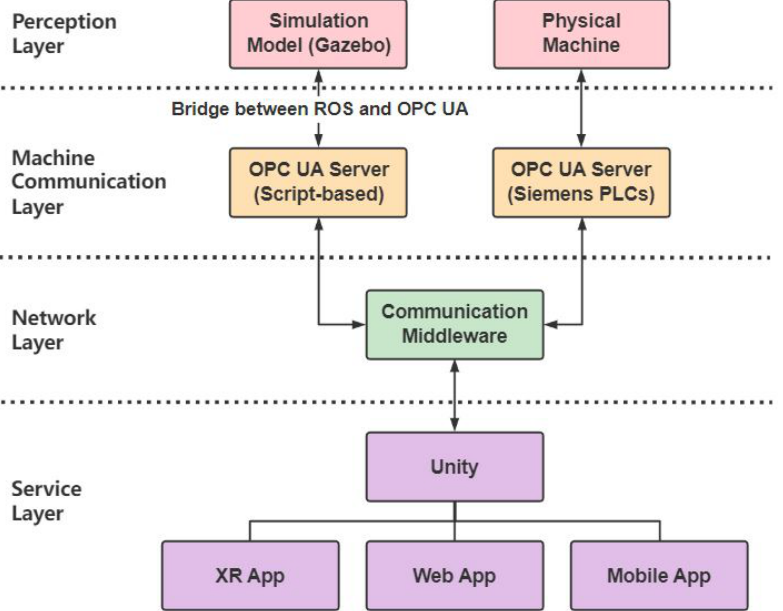
Figure 1. Framework and workflow of the applications for a DT-based crane. The whole framework contains four layers: the perception layer with the “Ilmatar” crane and its simulation mode; the machine communication layer assuring the standard data acquisition; the network layer focusing on communication with the external users; and the service layer providing various digital